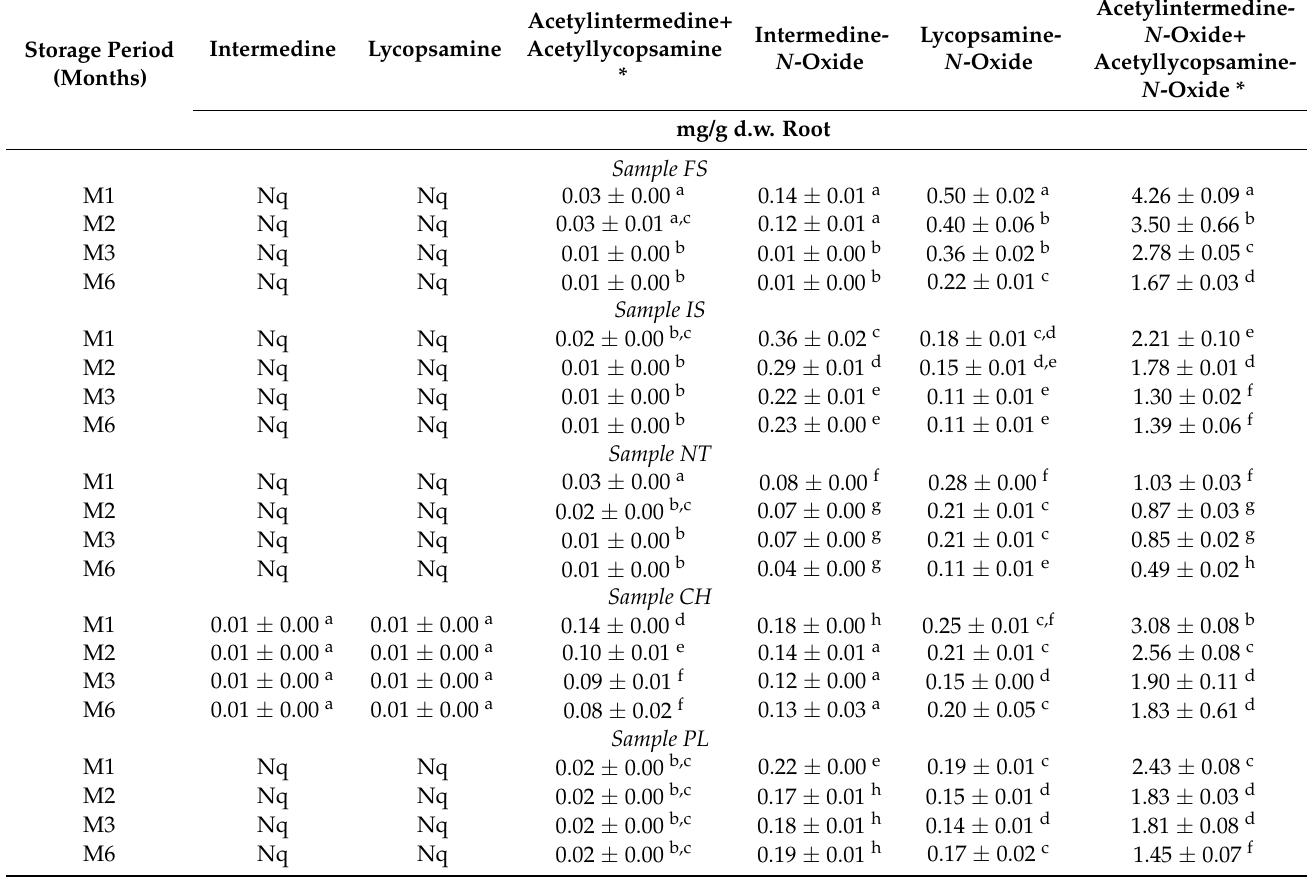
Table 2. Quantitative assessment of pyrrolizidine alkaloids in comfrey ( S. officinale ) roots collected from different European regions and stored for 1–6